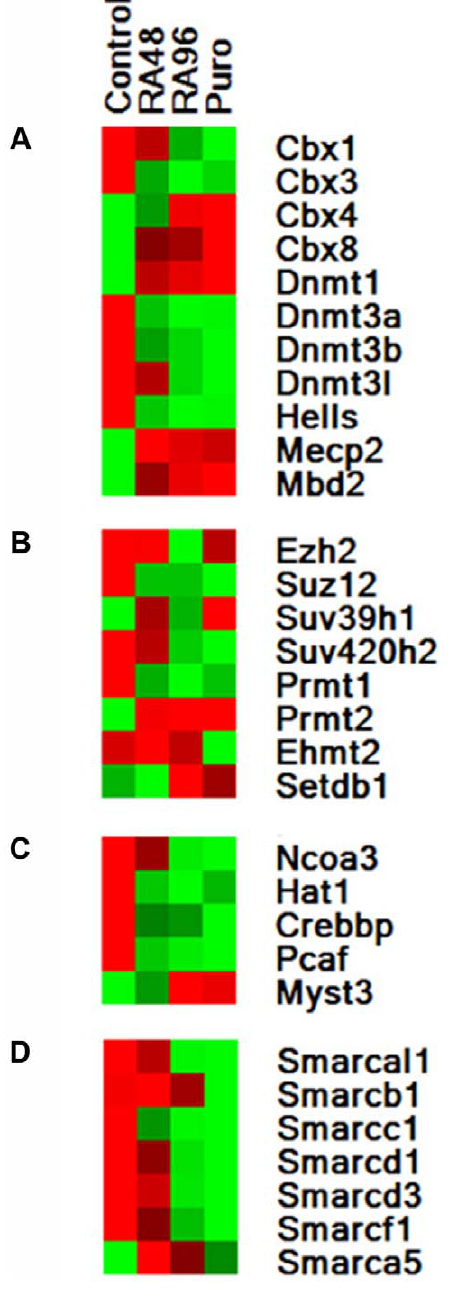
Figure 2. Differential regulation of selected chromatin remod- eling gene classes with SMC differentiation. A . DNA methyltrans- ferases. B . Histone methyltransferases. C . Histone acetyltransferases. D . SWI/SNF family. Row-normalized heatmaps are shown labeled with gene symbols. Control = untreated A404 cells. RA48/RA96 = Retinoic acid treated for 48 and 96 h respectively. Puro = Treated with RA for 96 hours, then puromycin for 48 hours. Green: down. Red: up.